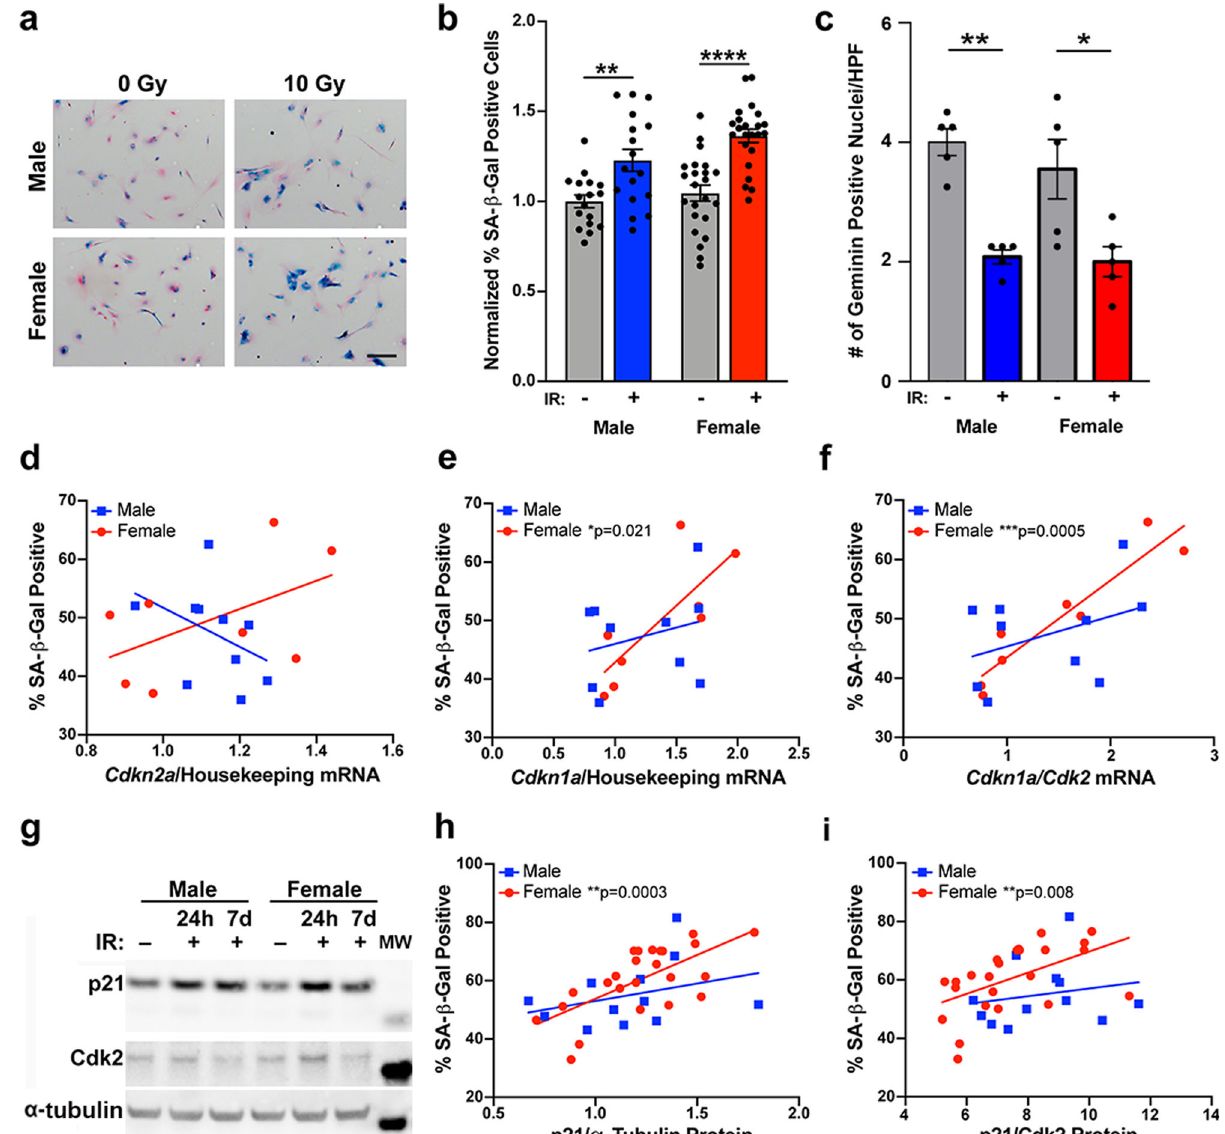
Fig. 5 Wild-type mouse astrocytes exhibit sex differences in the relationship between p21 and SA- β -gal positivity. a Example images of wildtype mouse astrocytes stained for SA- β -gal seven days after irradiation with 0 or 10 Gy, followed by counterstaining with nuclear fast red. Scale bar, 150 μ m. b Quanti fi cation of the percentage of SA- β -gal positive cells. Results are pooled from 3 separate experiments, representing a total of 17 male and 23 female pups across 7 litters. Values were normalized to the Male 0 Gy condition of the same experiment, which was arbitrarily set at 1. Two-way ANOVA: dose p < 0.0001, sex p = 0.0455, interaction p = 0.3676. ** p < 0.01, **** p < 0.0001 as indicated by bracket. Data are means + / − SEM ( n = 17 – 23/sex/ condition). c Number of Geminin positive nuclei per high-powered fi eld. Shown are the means + / − SEM and each of the individual replicate points ( n = 5/ sex/condition). Two-way ANOVA: dose p < 0.0001, sex p = 0.3948, interaction p = 0.5561. * p = 0.0145 and ** p = 0.0024 as indicated by bracket. d Correlation between Cdkn2a (p16) mRNA levels at 24 h after irradiation with 0 or 10 Gy and the percentage of SA- β -gal positive cells at 7 days after irradiation in male and female wildtype astrocytes ( n = 10 male/8 female). e Correlation between Cdkn1a (p21) mRNA levels at 24 h after irradiation with 0 or 10 Gy and the percentage of SA- β -gal positive cells at 7 days after irradiation in male and female wildtype astrocytes. Male correlation: r = 0.28, p = 0.441, female correlation: r = 0.79, p = 0.0207 ( n = 10 male/8 female). f Correlation between the Cdkn1a/Cdk2 mRNA ratio at 24 h after irradiation with 0 or 10 Gy and the percentage of SA- β -gal positive cells at 7 days after irradiation in male and female wild-type astrocytes. Male correlation: r = 0.39, p = 0.2608, Female correlation: r = 0.94 p = 0.0005 ( n = 10 male/8 female). g Representative western blot images of p21 and Cdk2 in non-irradiated and irradiated male and female wild-type astrocytes at 24 h, and irradiated male and female wild-type astrocytes at 7 days. Molecular weight markers (MW): p21 (15 kDa), Cdk2 (30 kDa), α -Tubulin (50 kDa). h Correlation between p21 protein levels at 24 h after irradiation with 0 or 10 Gy and the percentage of SA- β -gal positive cells at 7 days after irradiation in male and female wild-type astrocytes. Male correlation: r = 0.33, p = 0.2909, female correlation: r = 0.67, p = 0.0003 ( n = 12 male/24 female). i Correlation between the p21/Cdk2 protein ratio at 24 h after irradiation with 0 or 10 Gy and the percentage of SA- β -gal positive cells at 7 days after irradiation in male and female wildtype astrocytes. Male correlation: r = 0.20, p = 0.5418, Female correlation: r = 0.53, p = 0.0081 ( n = 12 male/24 female).